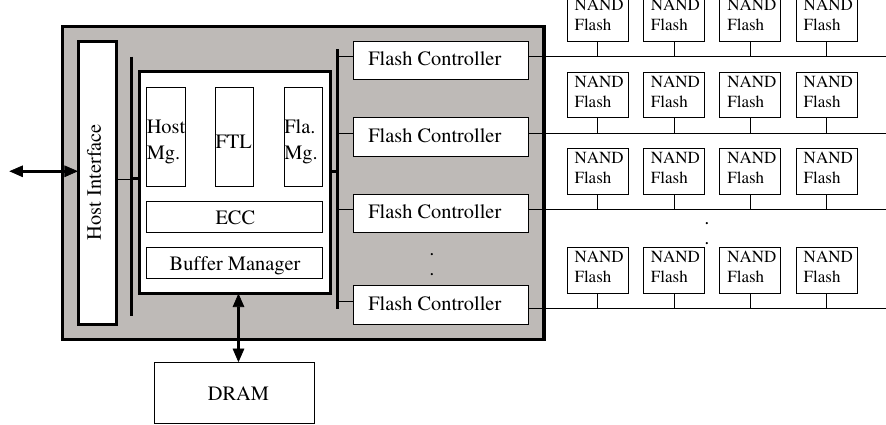
Figure 1. Basic architecture for NAND flash-based storage